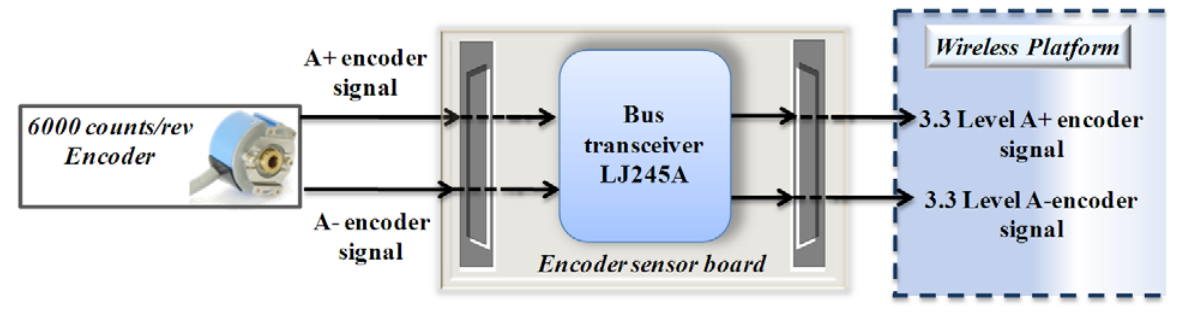
Figure 11. Block diagram encoder signal